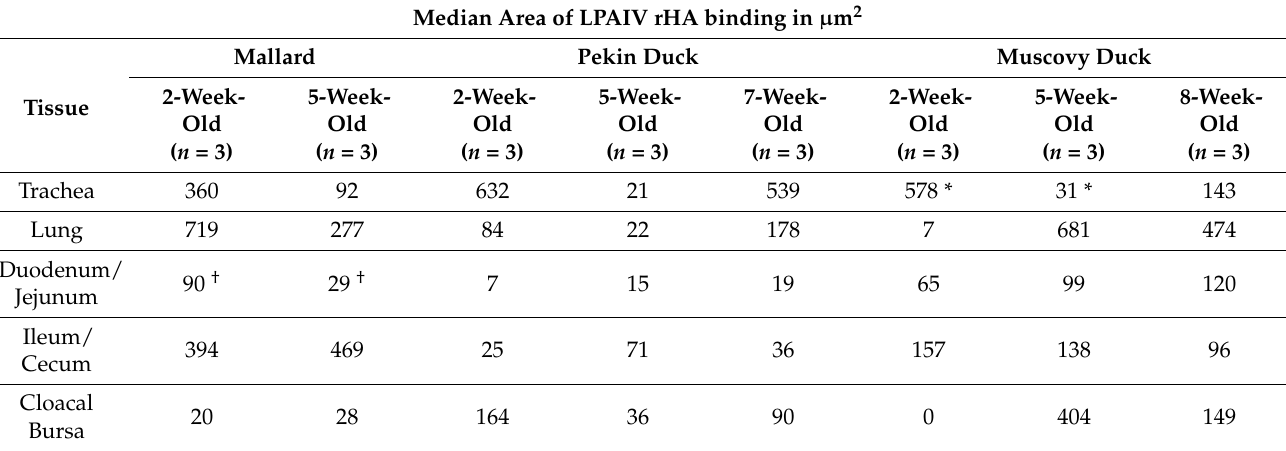
Table 3. Median area of binding (MAB) in µ m 2 of LPAIV rHA in the trachea, lung, small intestine, large intestine, and cloacal bursa of Mallard ducks, Pekin ducks, and Muscovy ducks of different age groups.